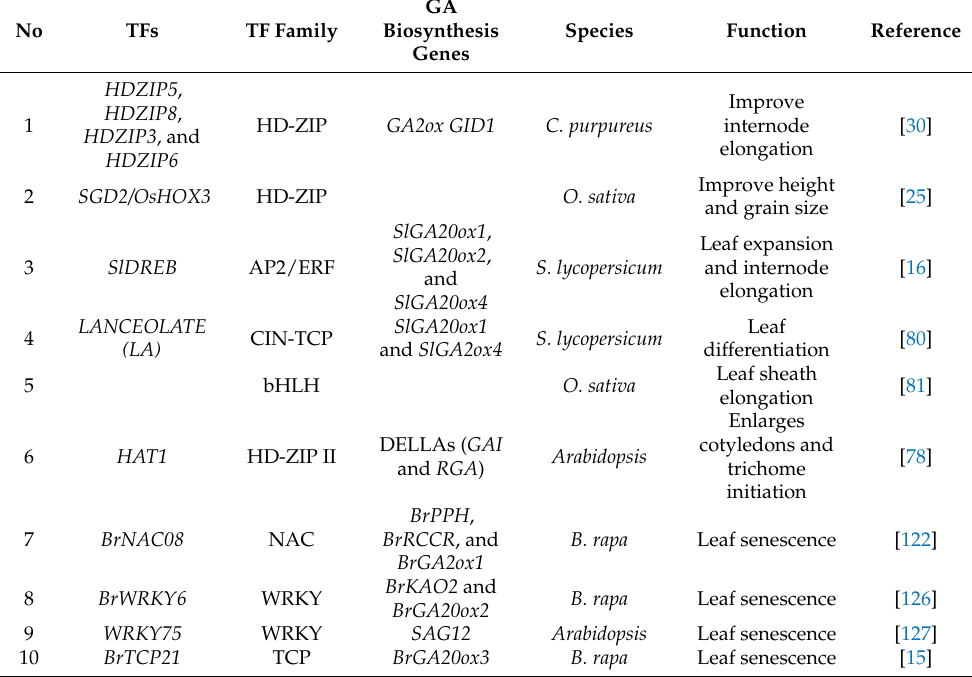
Table 2. TFs related to GA biosynthesis in